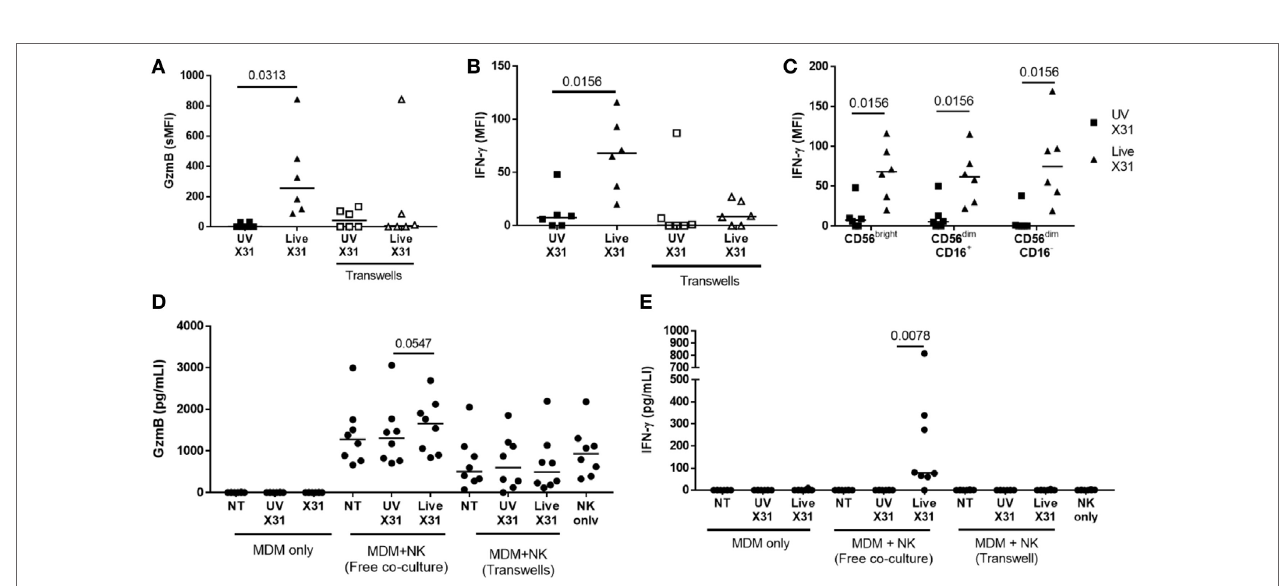
FigUre 10 | Peripheral blood natural killer (NK) cells produce IFN- γ and granzyme-B (GzmB) after contact with X31-infected cells. (a,B) Intracellular accumulation of GzmB and IFN- γ was measured by flow cytometry 6 h after culture with X31-infected monocyte-derived macrophages (MDMs). Physical separation of MDMs and NK cells in a transwell system abrogated IFN- γ and GzmB production ( N = 6). (c) Intracellular IFN- γ of CD56 bright and CD56 dim NK cell subsets when cultured with MDMs treated with UV-irradiated X31 and live-X31. (D,e) Extracellular secretion of GzmB (D) and IFN- γ (e) . Lines describe medians, statistical analysis by Wilcoxon signed-rank